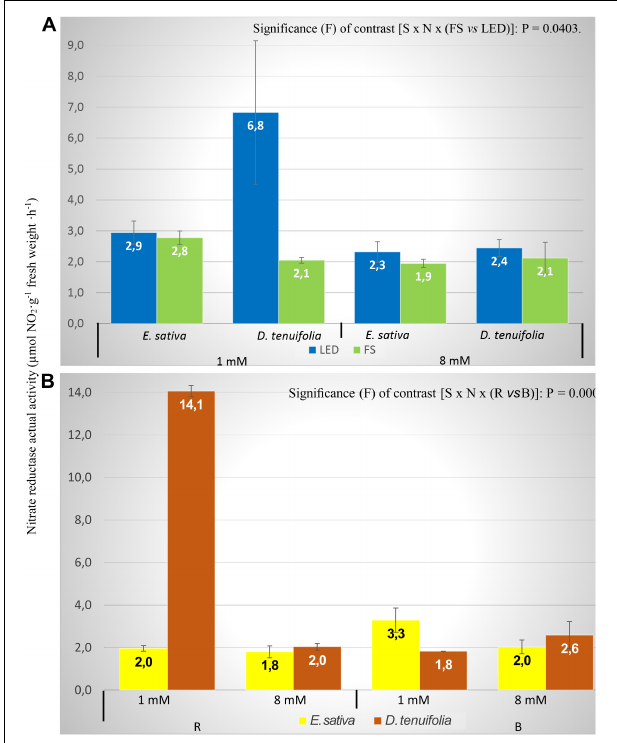
FIGURE 3 | Nitrate reductase actual activity (NRact) of rocket leaves in function of interactions species × nitrogen level × light (A) and species x light spectrum (B) . Vertical bars represent the standard error. S, species ( E. sativa and D. tenuifolia ); N, nitrogen level into the nutrient solution (1 and 8 mM); B, BLUE, peak at 460 nm; R,